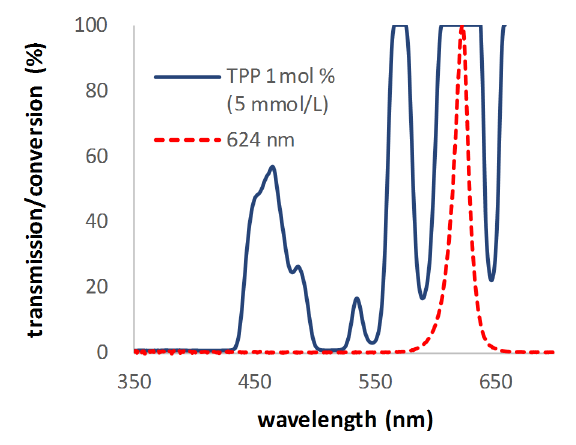
Figure 3: Measured transmission spectrum of a 5 mmol/L (1 mol %) solution of TPP ( H ) in dichloromethane with 0.5 N citronellol and the emission spectrum of the LED with an emission maximum at 624